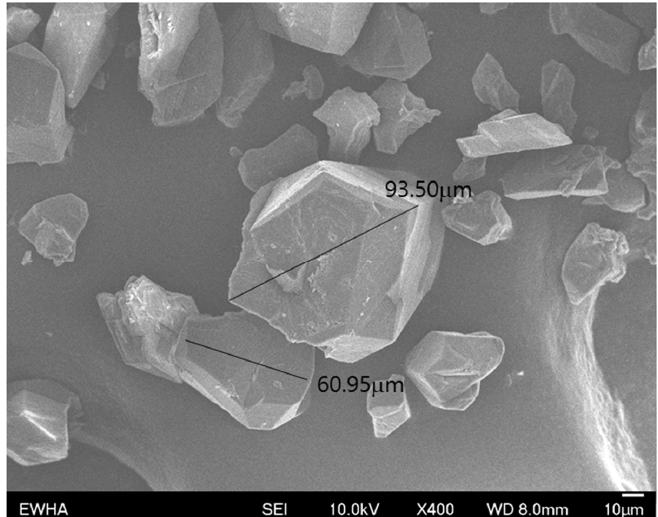
Figure 1. SEM image of Cu(AZPY)-MOF. In addition, MOF degradation tests were performed in H 2 O and PBS to confirm the stability of Cu(AZPY)-MOF . The amount of Cu II ions released from Cu(AZPY)-MOF was measured by inductively coupled plasma mass spectrometry (ICP-MS) after 1 day and 4 days (Figure S3). The amount of Cu II ions released from Cu(AZPY)-MOF after 1 day was 2.34 × 10 − 4 mg/mL, which is negligible compared to the 99% inactivating property of 0.5 mg/mL.